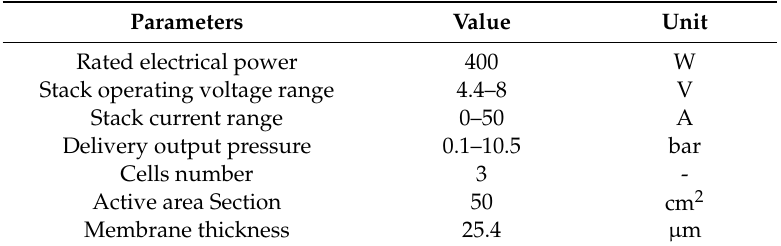
Figure 4. Realized experimental test bench in laboratory. Table 1. Technical data of the investigated PEM